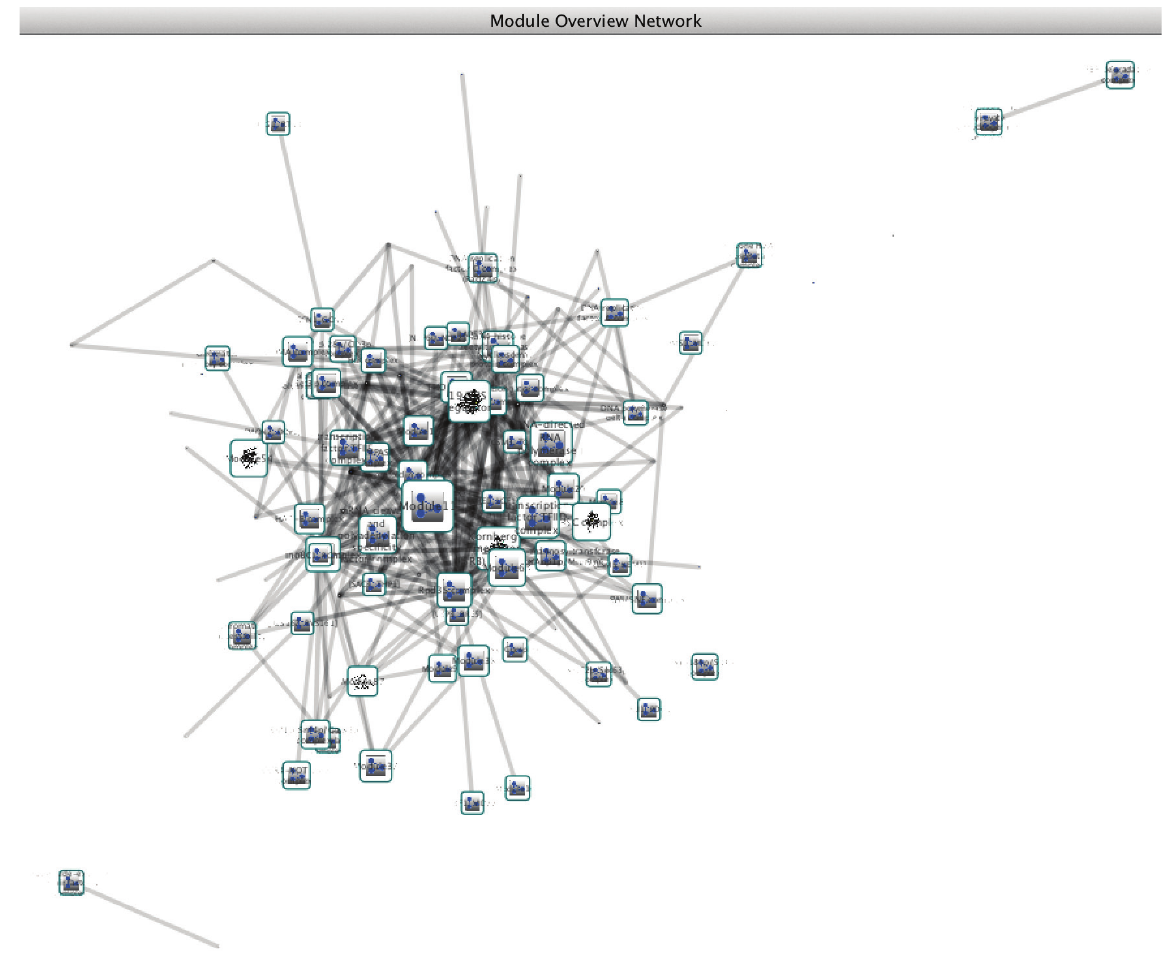
Figure 1. The module overview